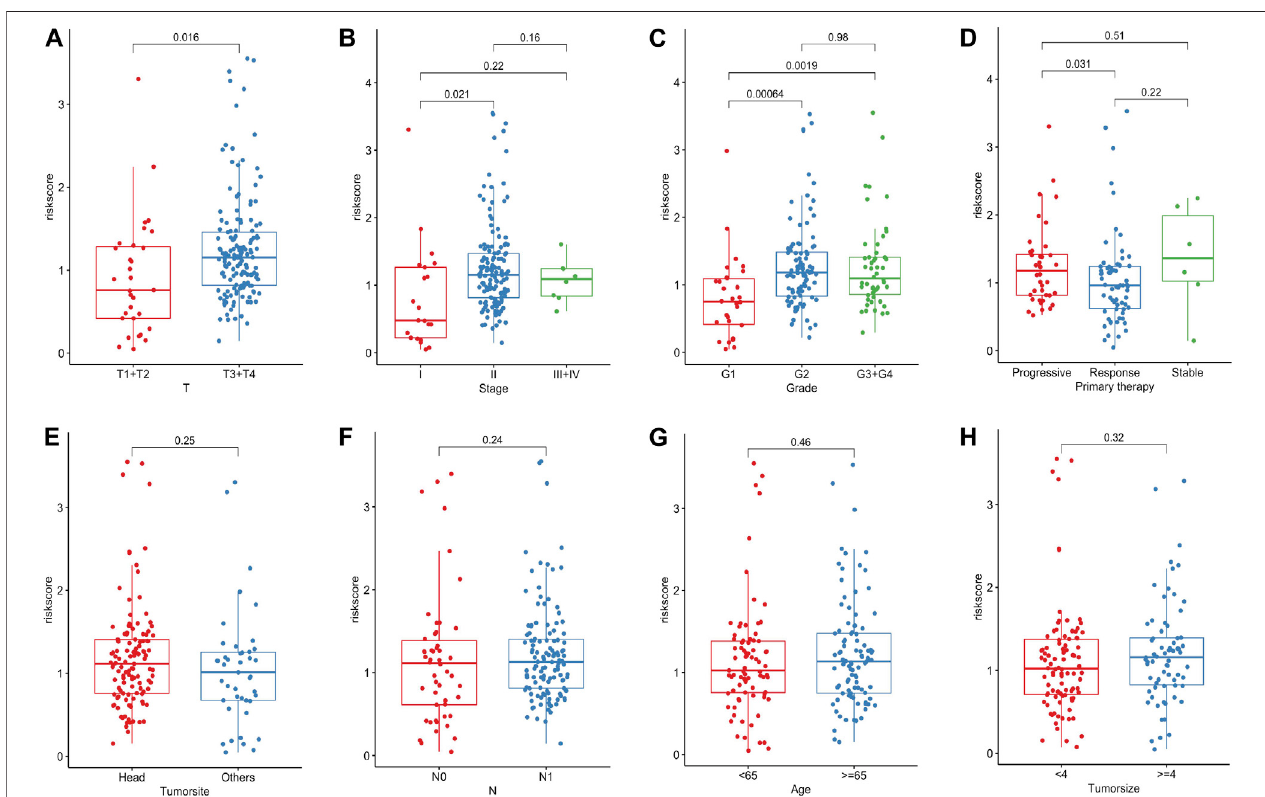
FIGURE 5 | The risk score signi fi cantly correlated with pathological T stage, TNM stage, grade and primary therapy outcome of PC patients (A – D) . The risk score was not related to the tumor site, pathological N stage, age and tumor size (E – H) .